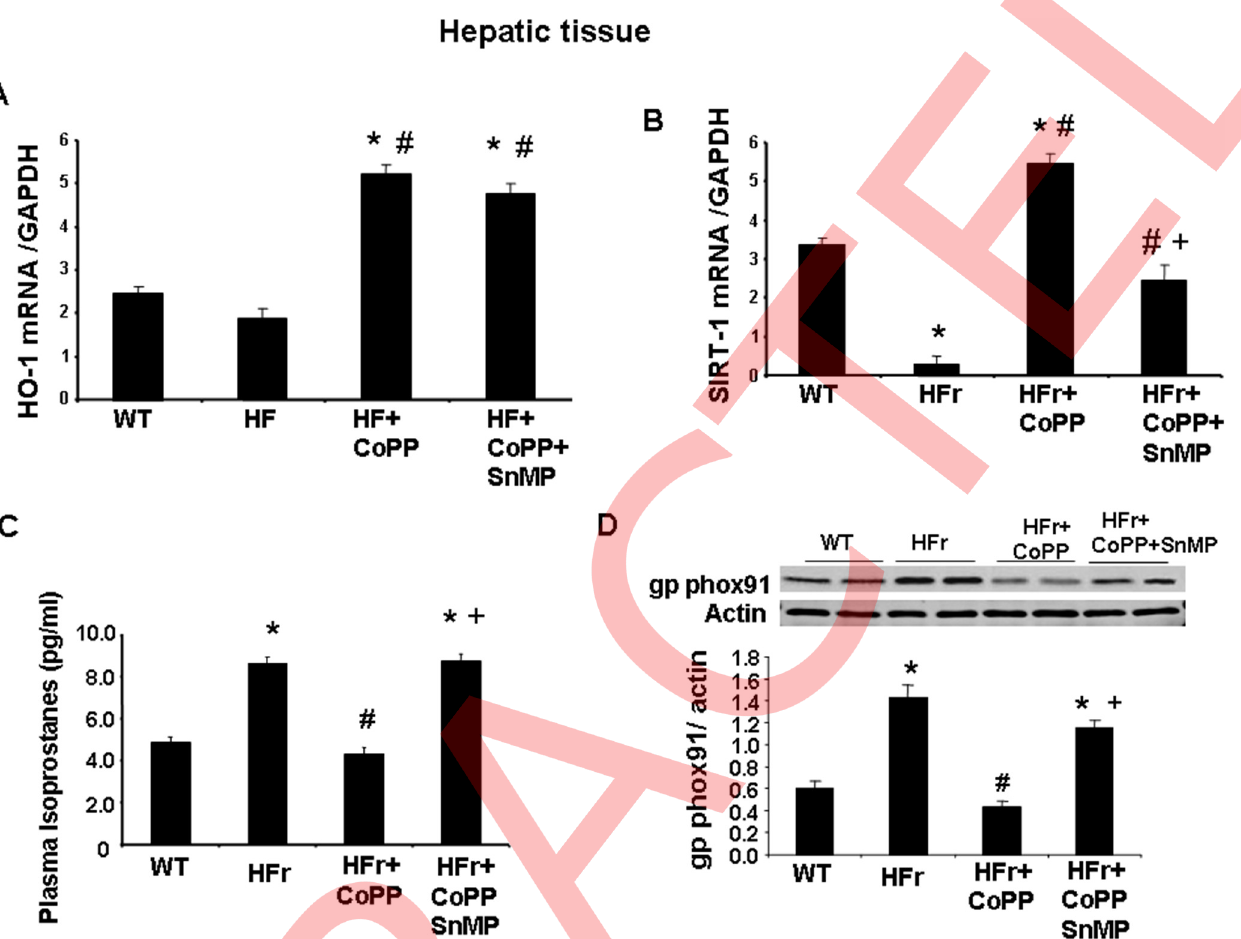
Fig 5. Effect of induction of HO-1 (CoPP) and inhibition of HO (SnMP) in mice fed a high fructose diet for 8 weeks on HO-1 mRNA, SIRT1 mRNA, plasma isoprostane and gp phox91 protein expression. (A) HO-1 mRNA levels measured by RT-PCR. (B) SIRT1 mRNA levels measured by RT-PCR. (C) Plasma isoprostane levels and (D) gp phox91 protein expression. Results are mean ± SE, n = 6/group. � p < 0.05 vs CTR; # p < 0.05 vs HFr, + p < 0.05 vs HFr +CoPP.